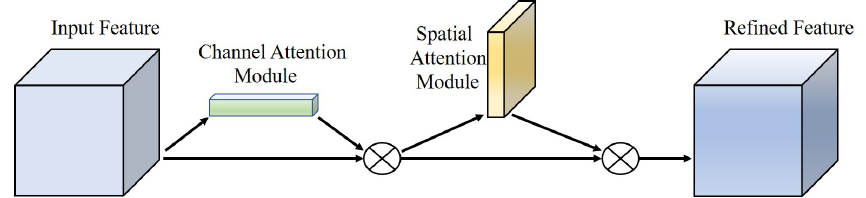
Figure 4. The structure of Convolutional Block Attention Module.